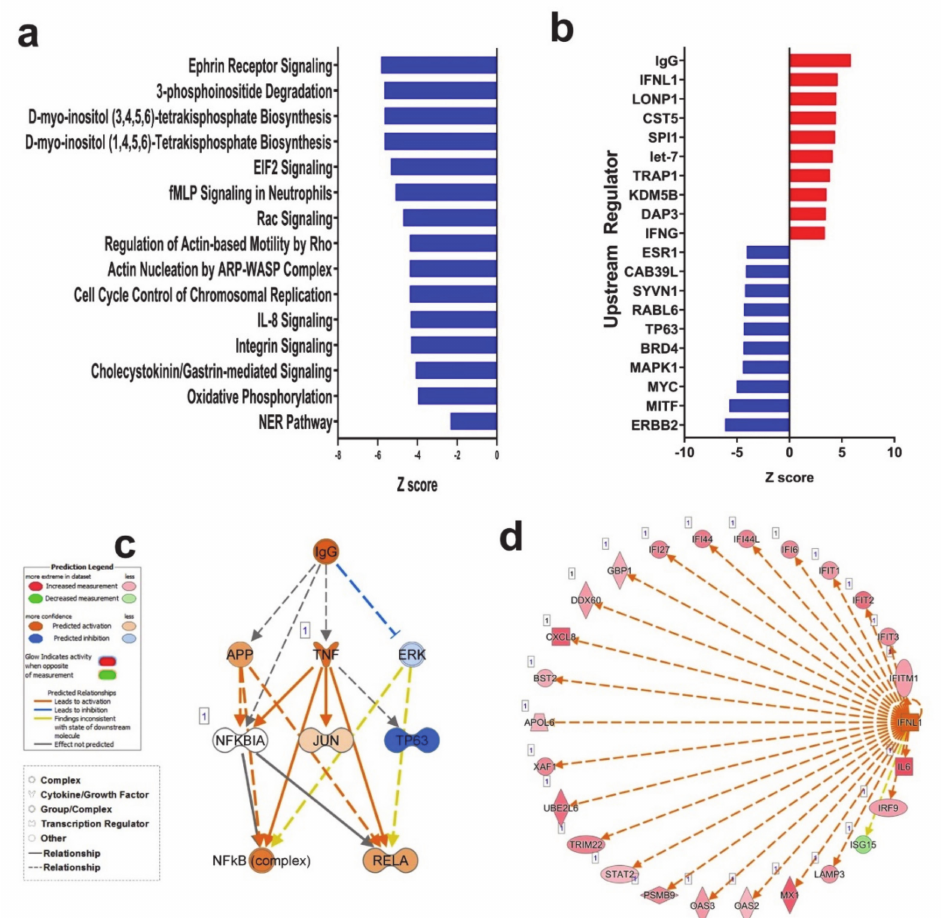
Figure 2. Ingenuity pathway analysis (IPA) of di ff erentially expressed gene in Control and SARS-CoV-2 infected NBHE cells. ( a ) Canonical IPA analysis of di ff erentially expressed genes in SARS-CoV-2 vs. control NBHE cells. X - axis indicates Z score while y -axis indicates the corresponding canonical pathways. Blue color indicates suppressed pathways. ( b ) Upstream regulator analysis of di ff erentially expressed genes in SARS-CoV-2 vs. control NBHE cells using IPA. IgG ( c ) and interferon lambda 1 (IFNL1, ( d )) mechanistic network and their activation state in SARS-CoV-2 infected NBHE cells based on IPA